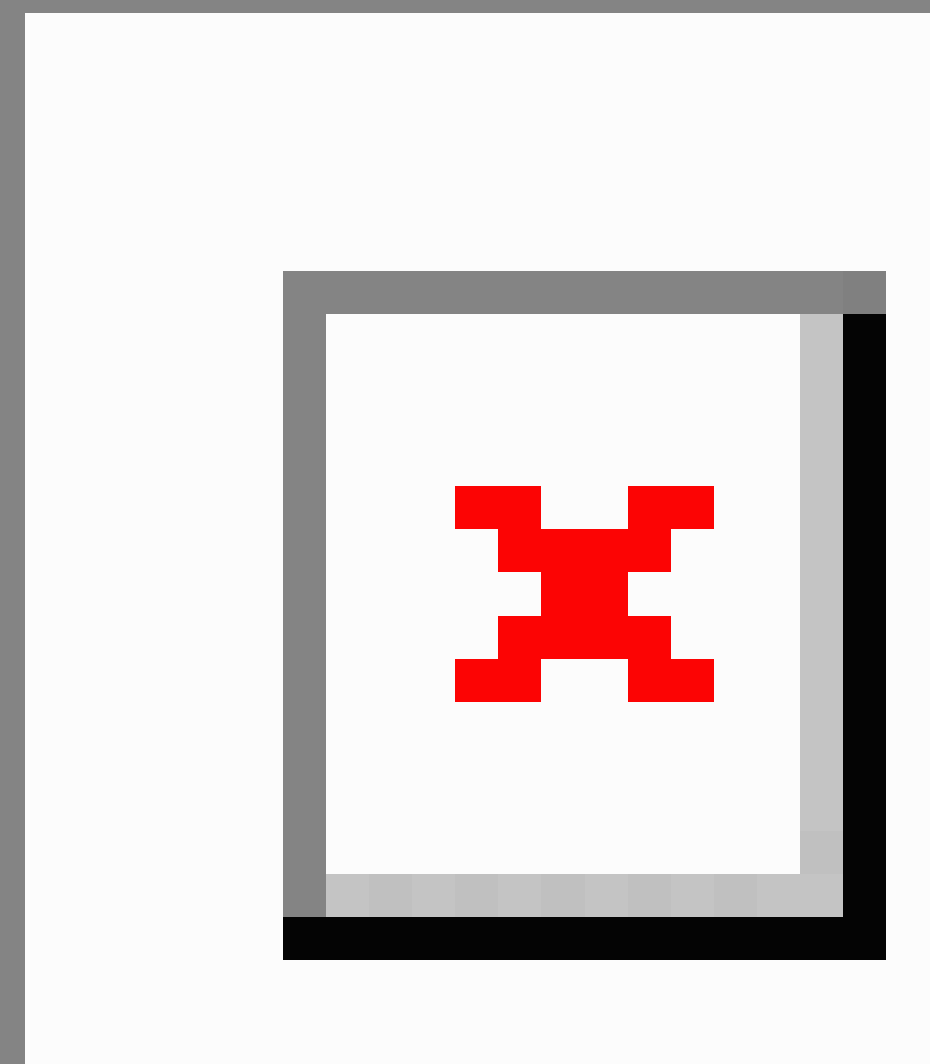
Figure 1. Response rates for online and offline